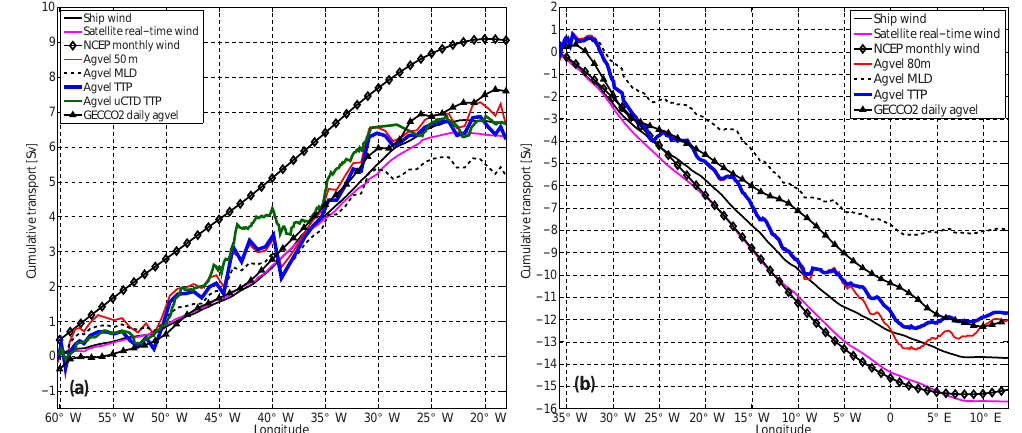
Figure 7. Cumulative meridional Ekman transport from the western to the eastern coast (a) at 14.5 ◦ N and (b) at 11 ◦ S. For both sections, the black solid curve marks the indirect Ekman transport estimate from the in situ wind stress; the magenta solid curve denotes that from the satellite wind stress; and the black diamond line denotes that from the NCEP/NCAR monthly wind stress. The solid blue curve denotes the direct estimate by integrating the ageostrophic velocity to the TTP, the red solid to a uniform depth (50m at 14.5 ◦ N and 80m at 11 ◦ S), and the black dashed line to the MLD. The black triangle line represents the direct estimate based on the GECCO2 daily data. The dark green line in (a) represents the direct estimate integrated to the TTP based only on the uCTD data.